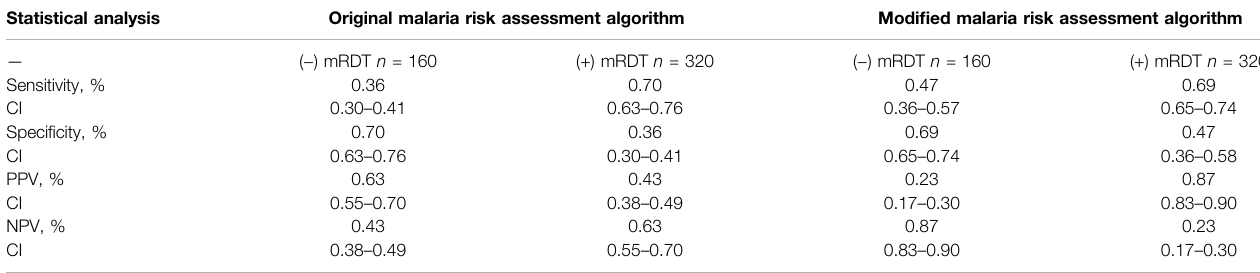
TABLE 5 | Performance statistics of modi fi ed vs. original malaria risk assessment algorithm compared to mRDT result. Statistical analysis